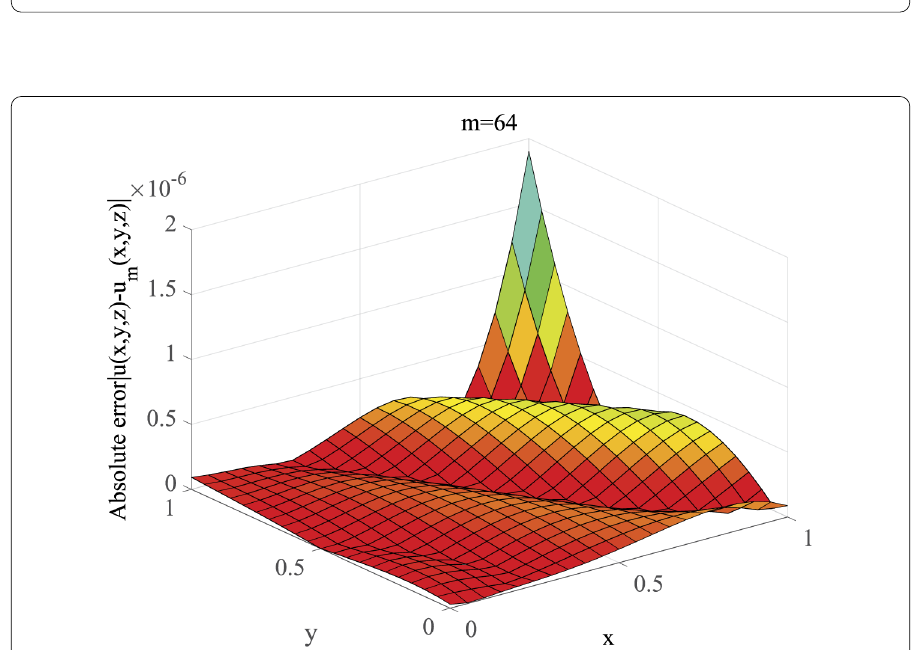
Figure 5 Absolute error e ( x , y , π ) for Example